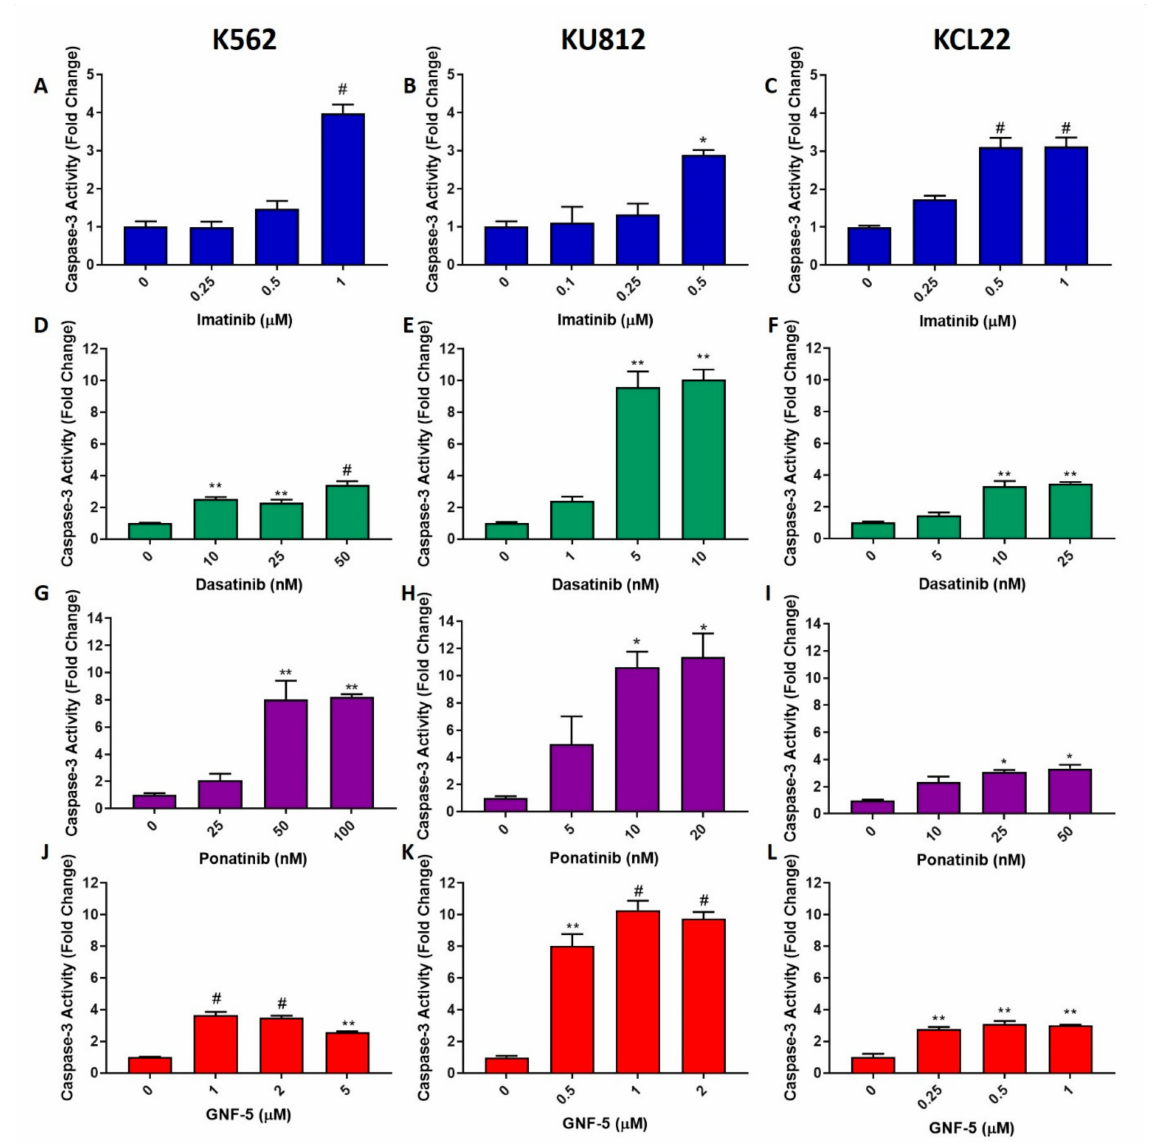
Figure 2. TKIs induce apoptosis in CML cells. K562, KU812 and KCL22 CML cells were treated with either imatinib ( A – C ), dasatinib ( D – F ) or ponatinib ( G – I ) for 24 h or GNF-5 ( J – L ) for 48 h. Following this, caspase-3 activity assays were performed and these data are displayed in the figure. Results were analyzed via one-way ANOVAs with a Dunnett’s post hoc test. Statistical tests compared results between the treated cells and the untreated control. * = p < 0.05, ** = p < 0.01, # = p < 0.001. n = 3. Values displayed as mean ±